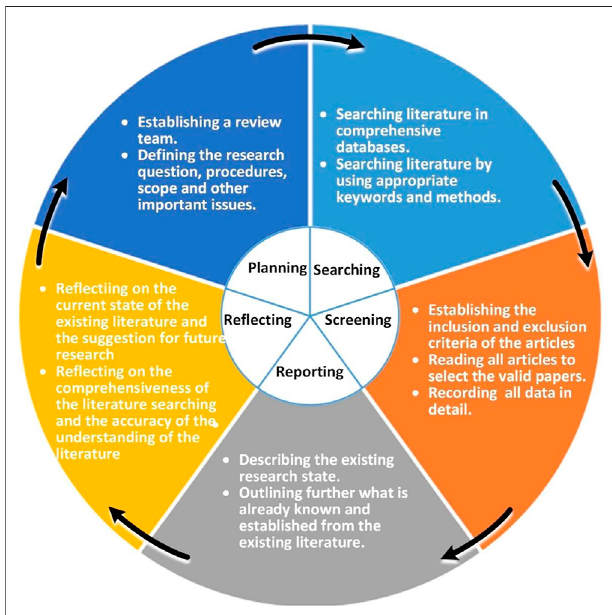
FIGURE 1 | The PSSRR Cycle of systematic literature